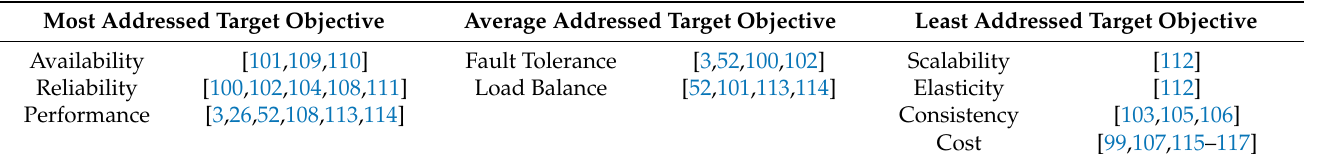
Table 5. Summary of all target objectives (Most addressed target objective, Average target objective, and Least target